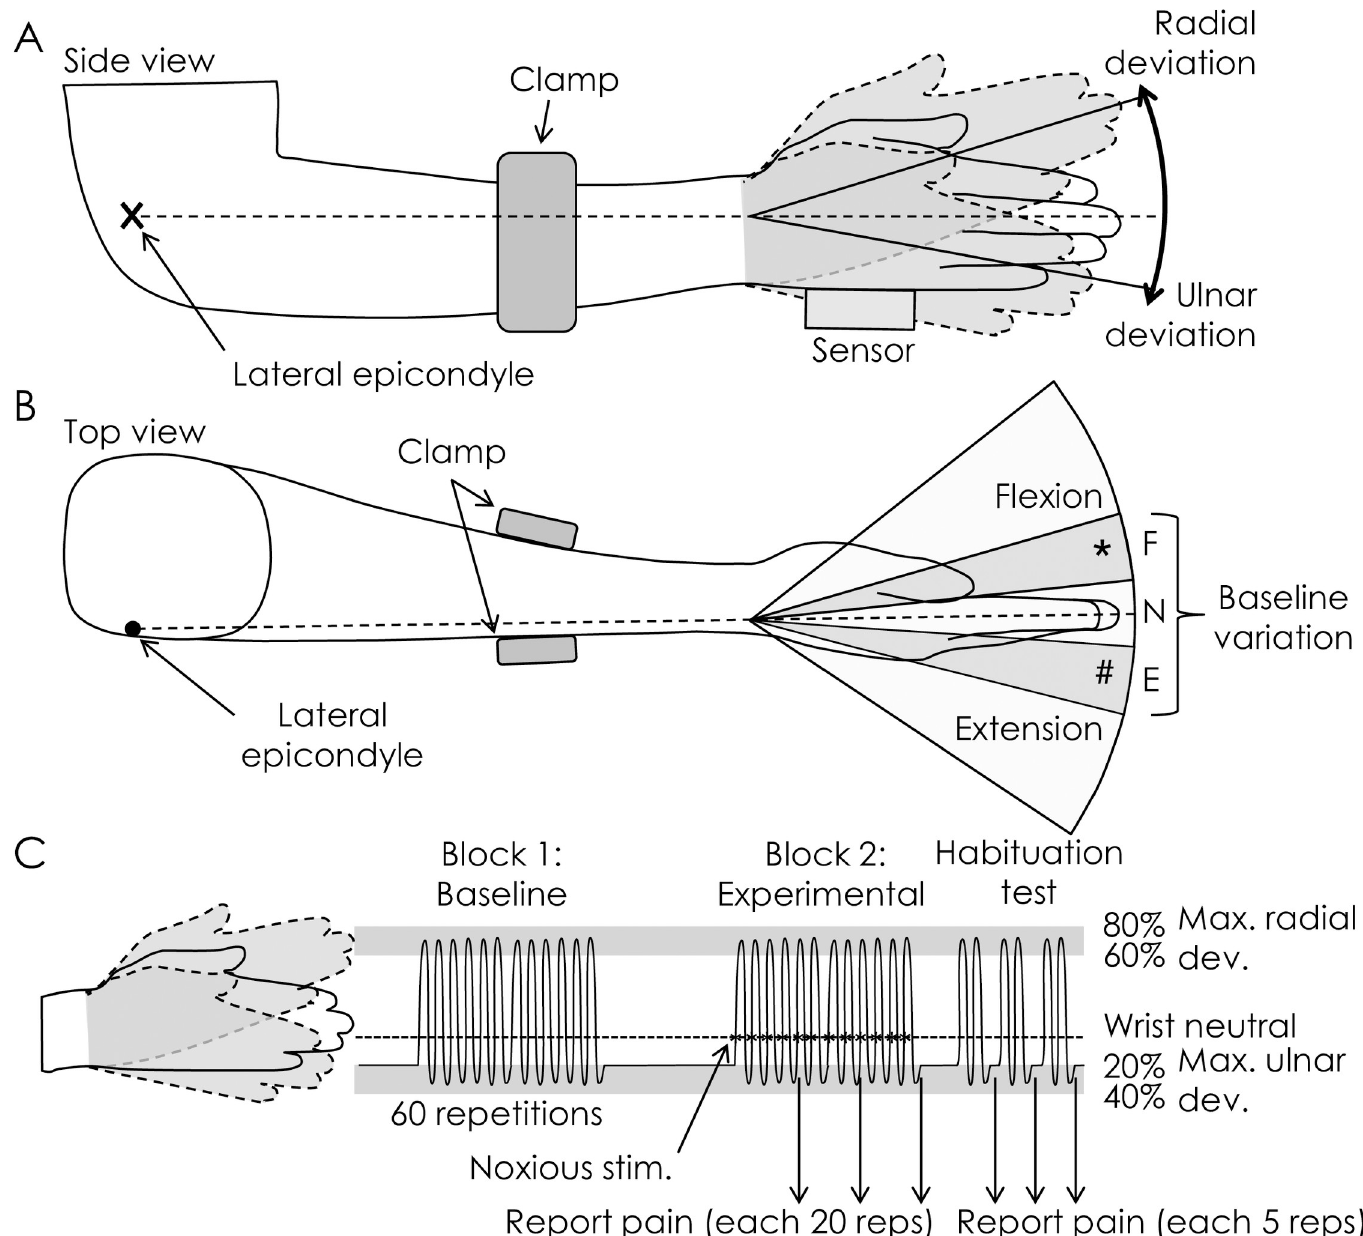
Fig 1. The experimental task involved repetitive radial-ulnar deviation movements between target regions in each direction. In the Pain 5–1 and Pain 5–0 experiments less or no, respectively, noxious stimulation was determined by the alignment of the wrist in the flexion-extension plane (B) as the wrist passed through radial-ulnar deviation neutral (A). The range of variation in the flexion and extension direction was identified in the Baseline condition and one third of this range was selected either in the flexion ( � ) or extension (#) direction. Movements performed with alignment in the flexion-extension plane in this target region either induced no stimuli or stimuli with reduced intensity. Panel C shows the timeline of the experiment. Max–maximum, dev–deviation, stim–stimulation, reps–repetitions.